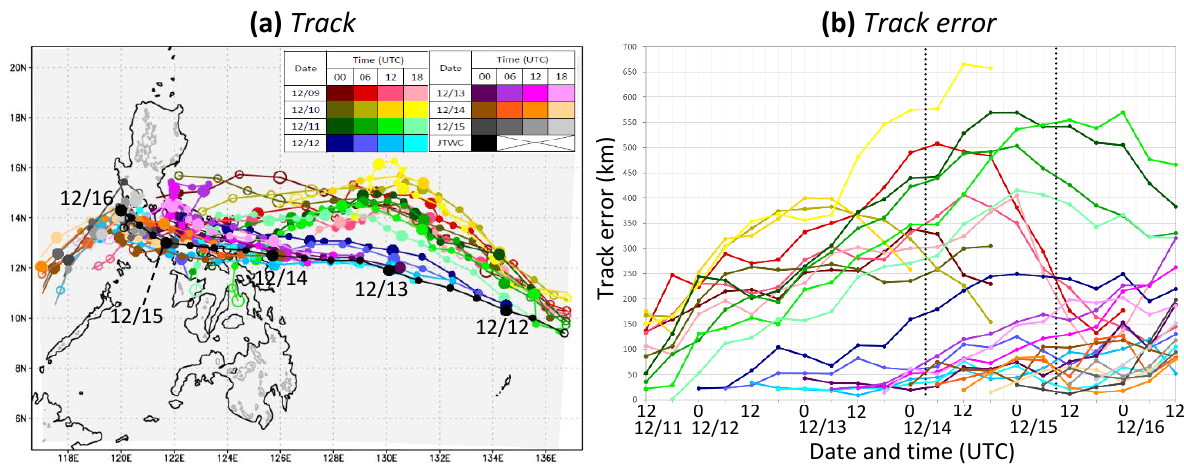
Figure 11. As in Figure 2, but for ( a ) the tracks and ( b ) track errors of TY Melor (2015) by the time-lagged forecasts, against the JTWC best track.